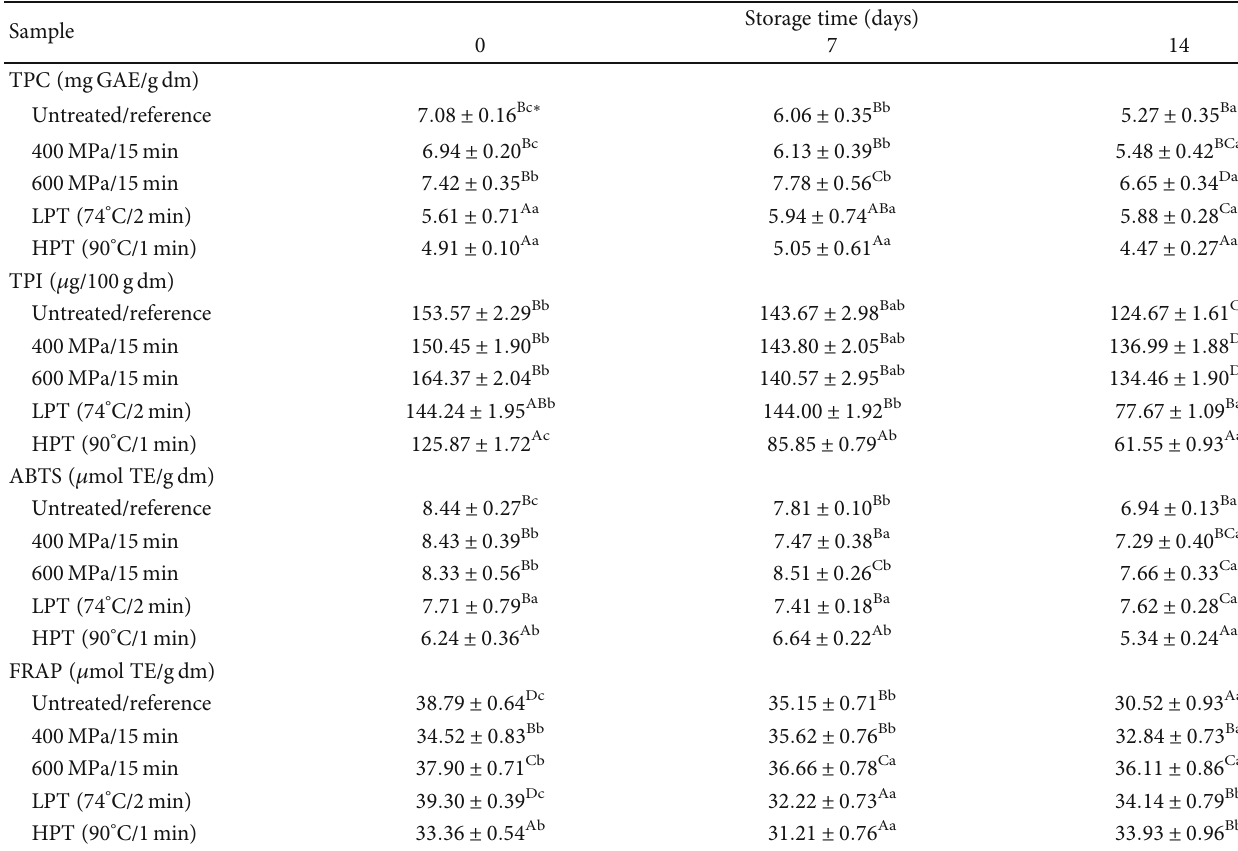
The results are expressed as the mean ± SD , n = 6 . ∗ Uppercase letters indicate di ff erences between treatment types (in columns) on particular days of storage, whereas lowercase letters indicate di ff erences between storage times for individual samples (in lines) ( p ≤ 0 : 05